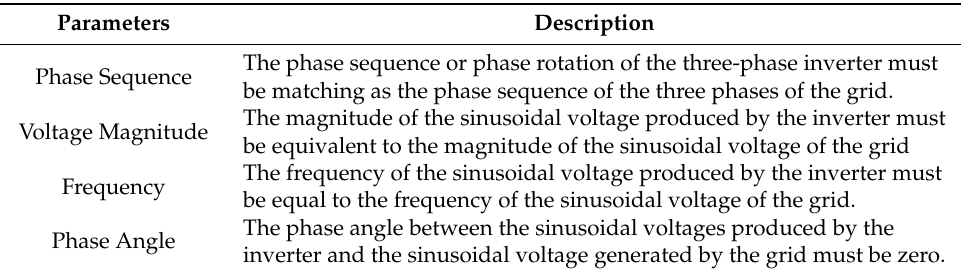
Table 3. Grid-synchronization Parameters [76,77].